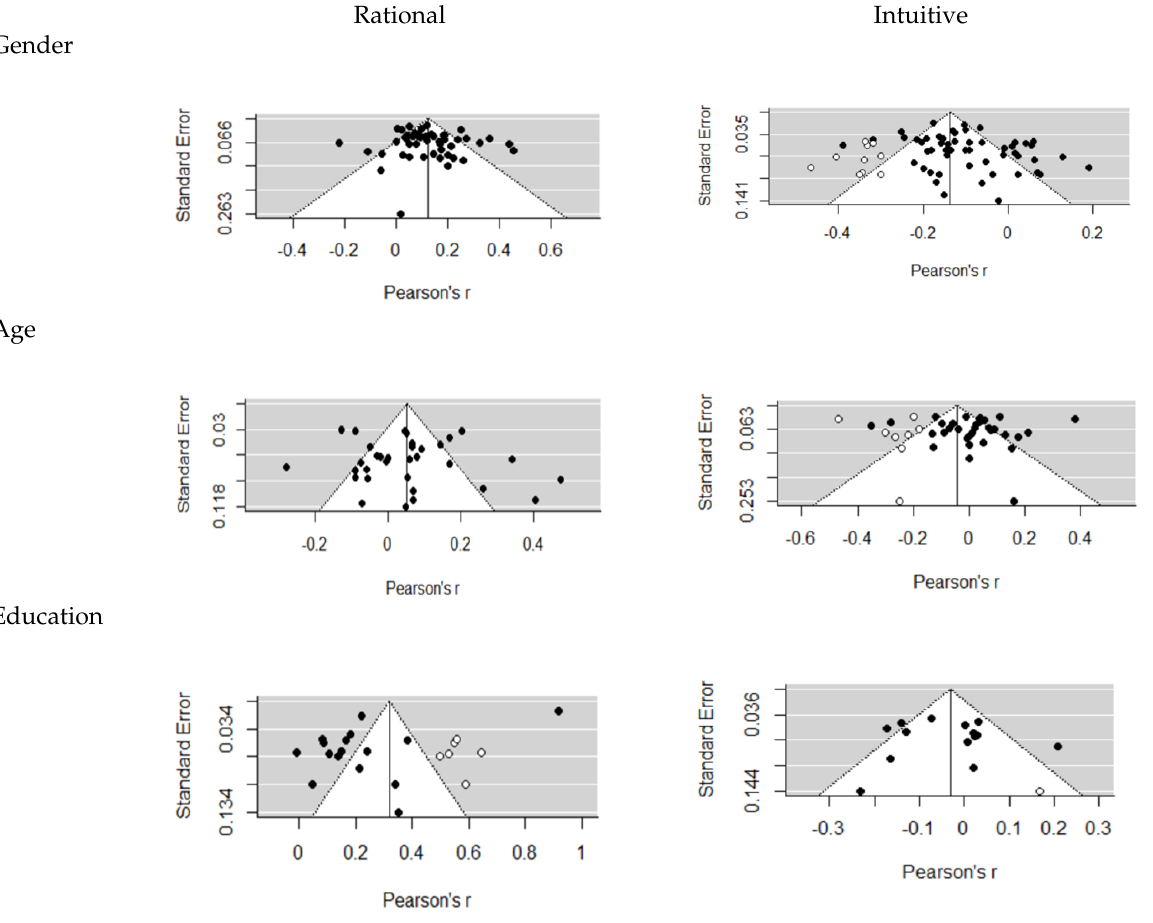
Figure 1: Funnel plots for each meta-analysis. Note: The filled circles represent the observed effects sizes, whereas the open circles represent effects sizes that are imputed by the trim-and-fill